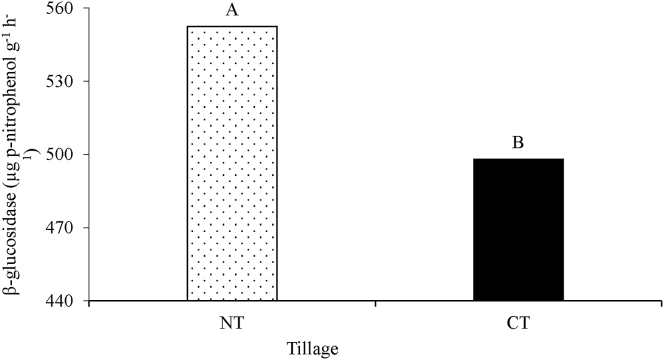
Tillage effects on β-glucosidase activity. Different uppercase letters indicate significant differences at P ≤ 0.05. NT: no-till and CT: conventional tillage.